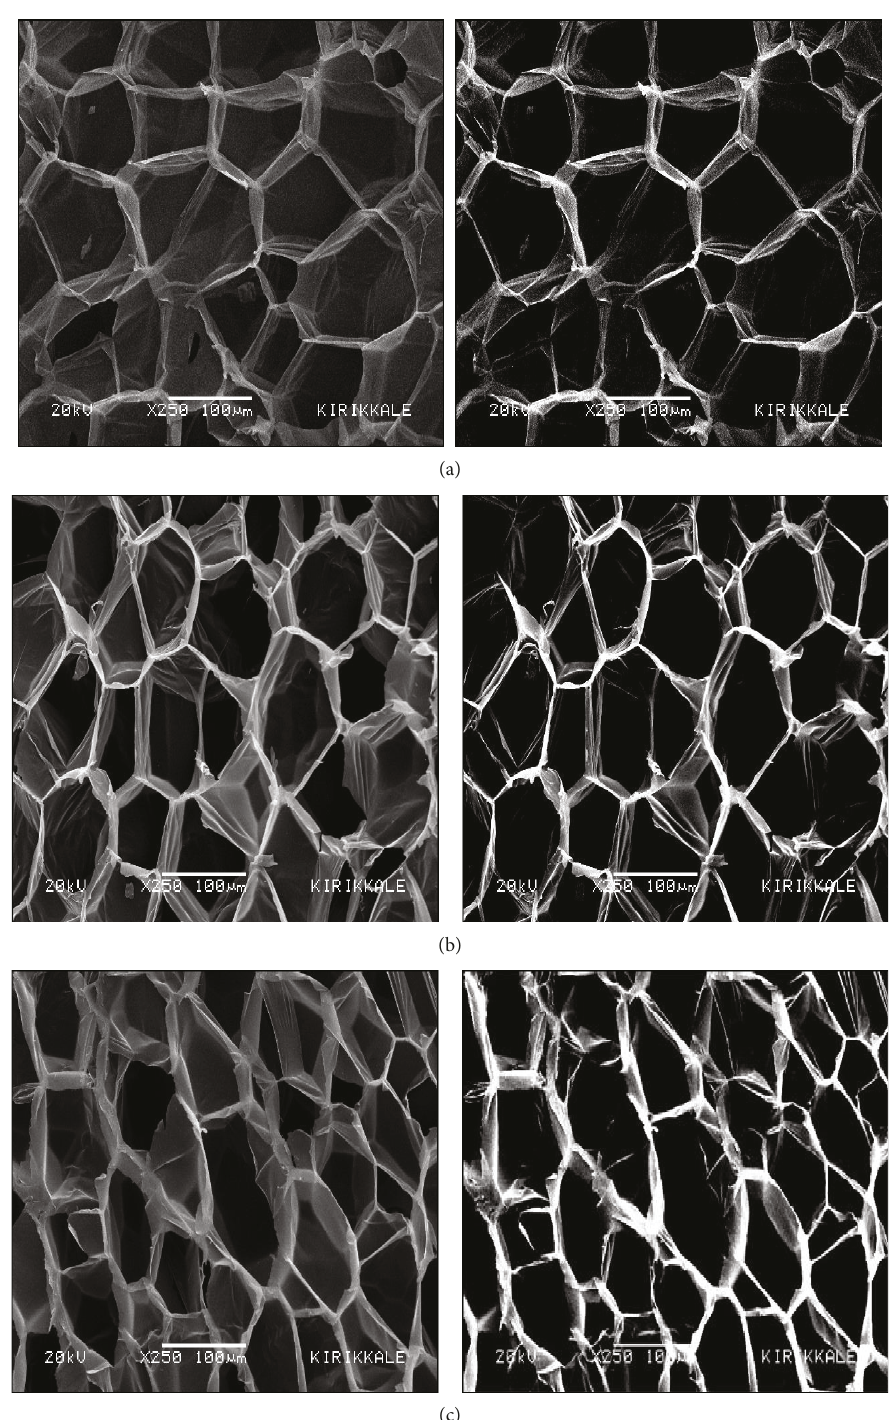
Figure 7: The electron microscope and image analysis pictures selected for the model design: (a) 16 kg/m 3 , (b) 21kg/m 3 , and (c) 25 kg/m 3